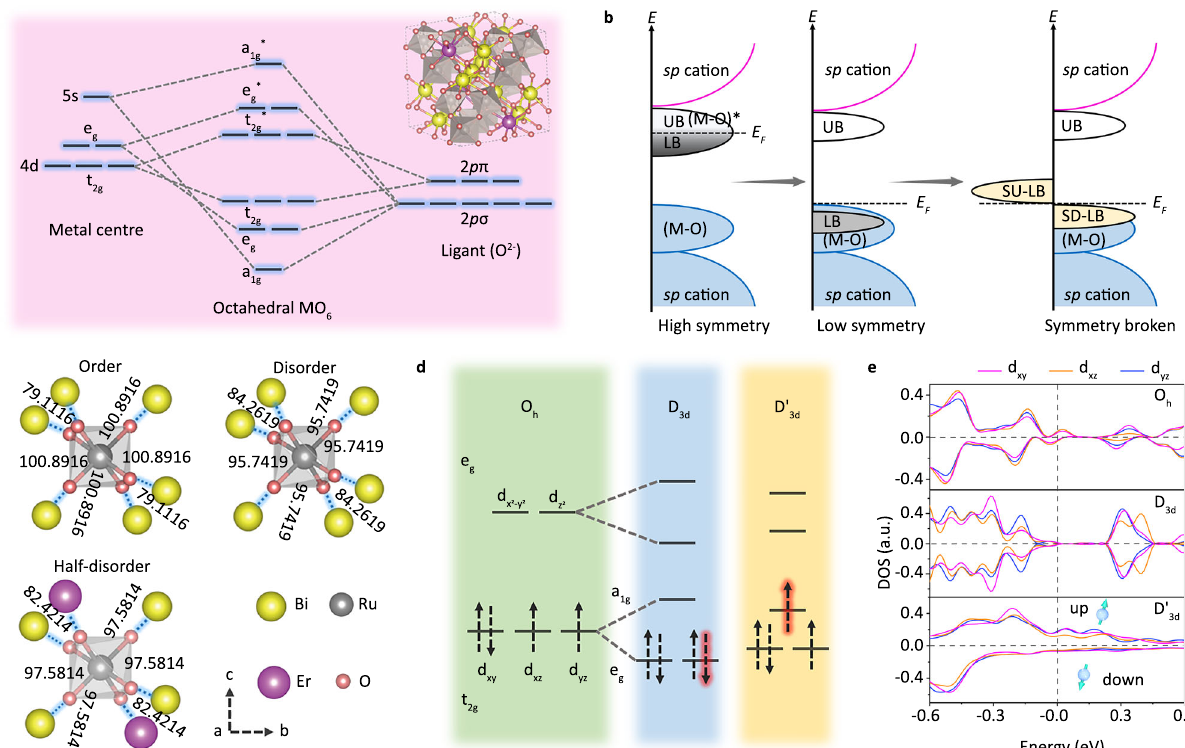
Fig. 1 Reaction mechanism design. a The molecular orbital energy diagram for octahedral MO 6 . b Schematic formation of energy splitting and electronic structure transformation, E F represents the Fermi level. c The RuO 6 coordination polyhedron in different BERO samples with ordered, disordered and half- disordered con fi guration. d Ru-4 d orbital splitting for different symmetry. e Spin-resolved projected density of states (PDOS) for RuO 6 coordination polyhedron in different BERO